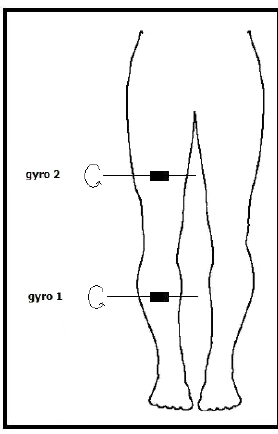
Figure 3. Position of the two gyroscopes on the human leg (body figure adopted from http://www.answers.com/body breadths).